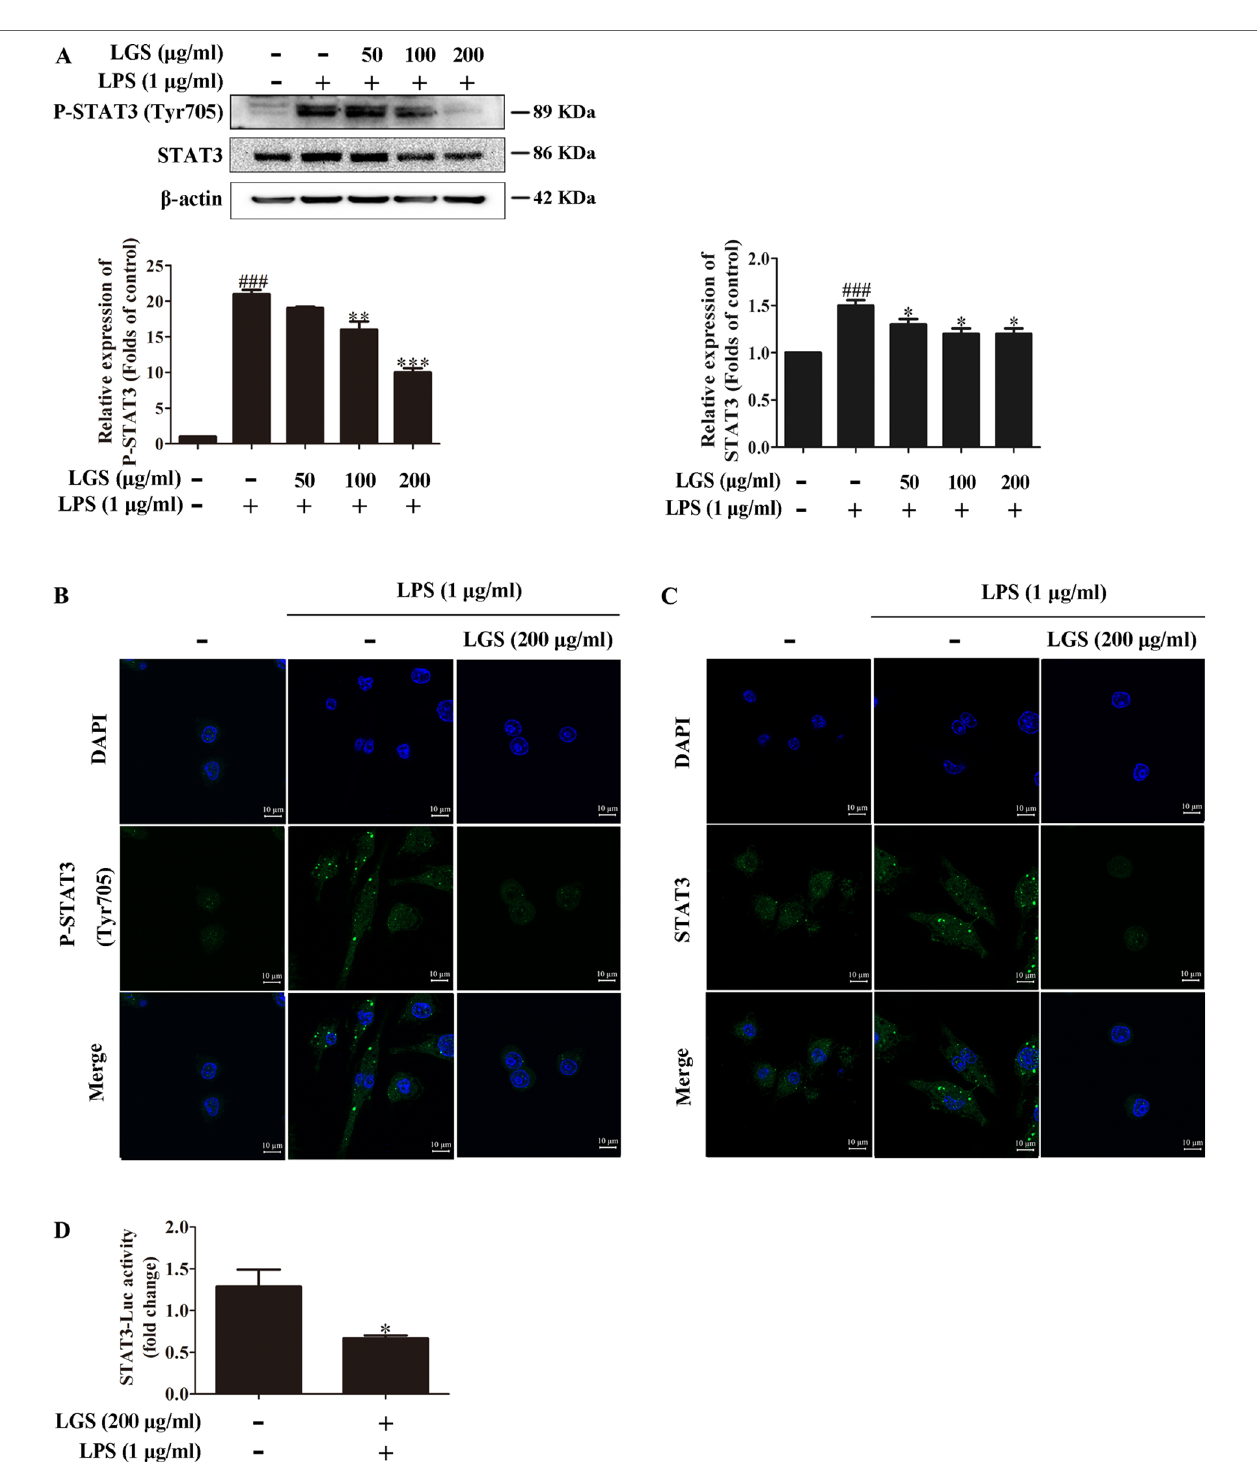
FIGURe 2 | LGS inhibits the STAT3 activation in LPS-induced RAW264.7 cells. (A−C) LGS inhibits the STAT3 signaling pathway. RAW264.7 cells were cultured with various concentrations of LGS in the presence or absence of LPS (1 μg/ml). The protein expressions of P-STAT3 (Tyr705) and STAT3 were measured by Western blotting (A) and confocal microscopy (600 ×) (B and C) , respectively. ### P < 0.001 versus control, * P < 0.05, ** P < 0.01, *** P < 0.001 versus LPS treatment by one-way ANOVA with Tukey’s test. (D) LGS suppresses the transcriptional activity of STAT3. The RAW264.7 cells were incubated in 96-well plates for 24 h. After infected by adenovirus, cells were treated with LGS (200 μg/ml) for another 24 h. The luciferase activity was detected by Dual-Luciferase ® Reporter Assay System. Data are represented as the mean ± SEM of three independent experiments. * P < 0.05 versus control by Student’s t -test.